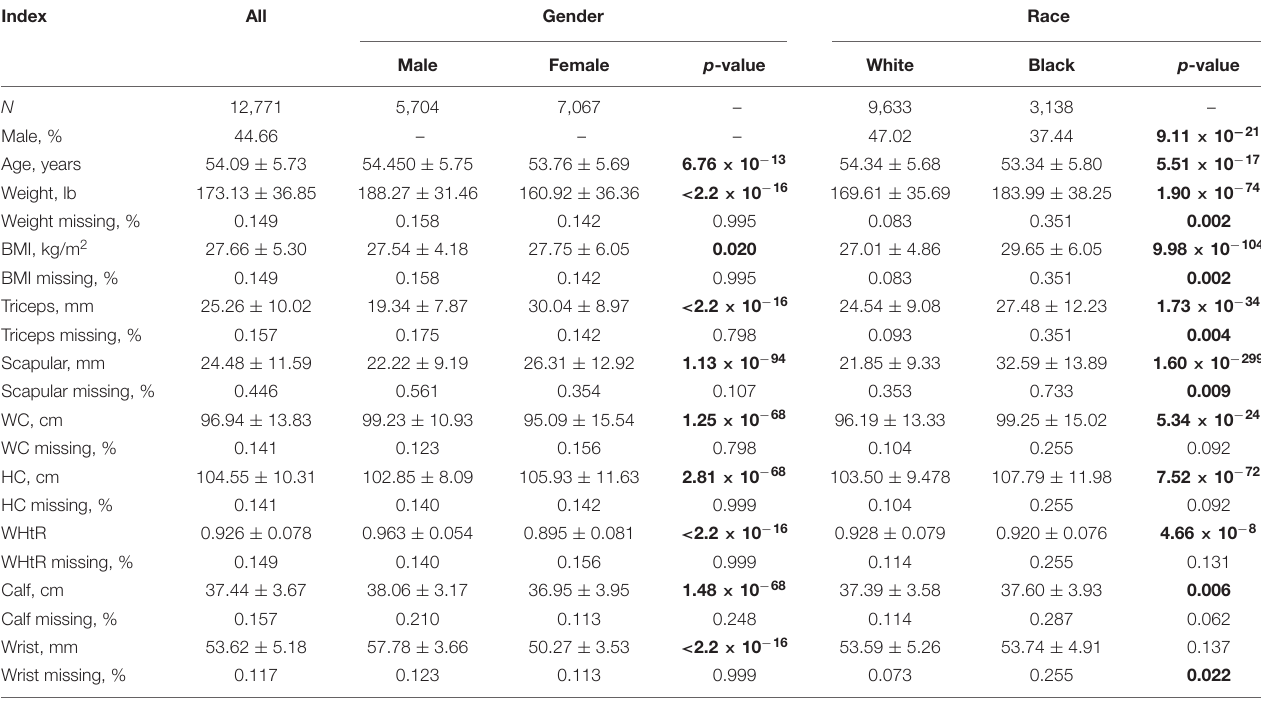
TABLE 3 | Summary statistics of obesity-related indexes and covariates in ARIC.